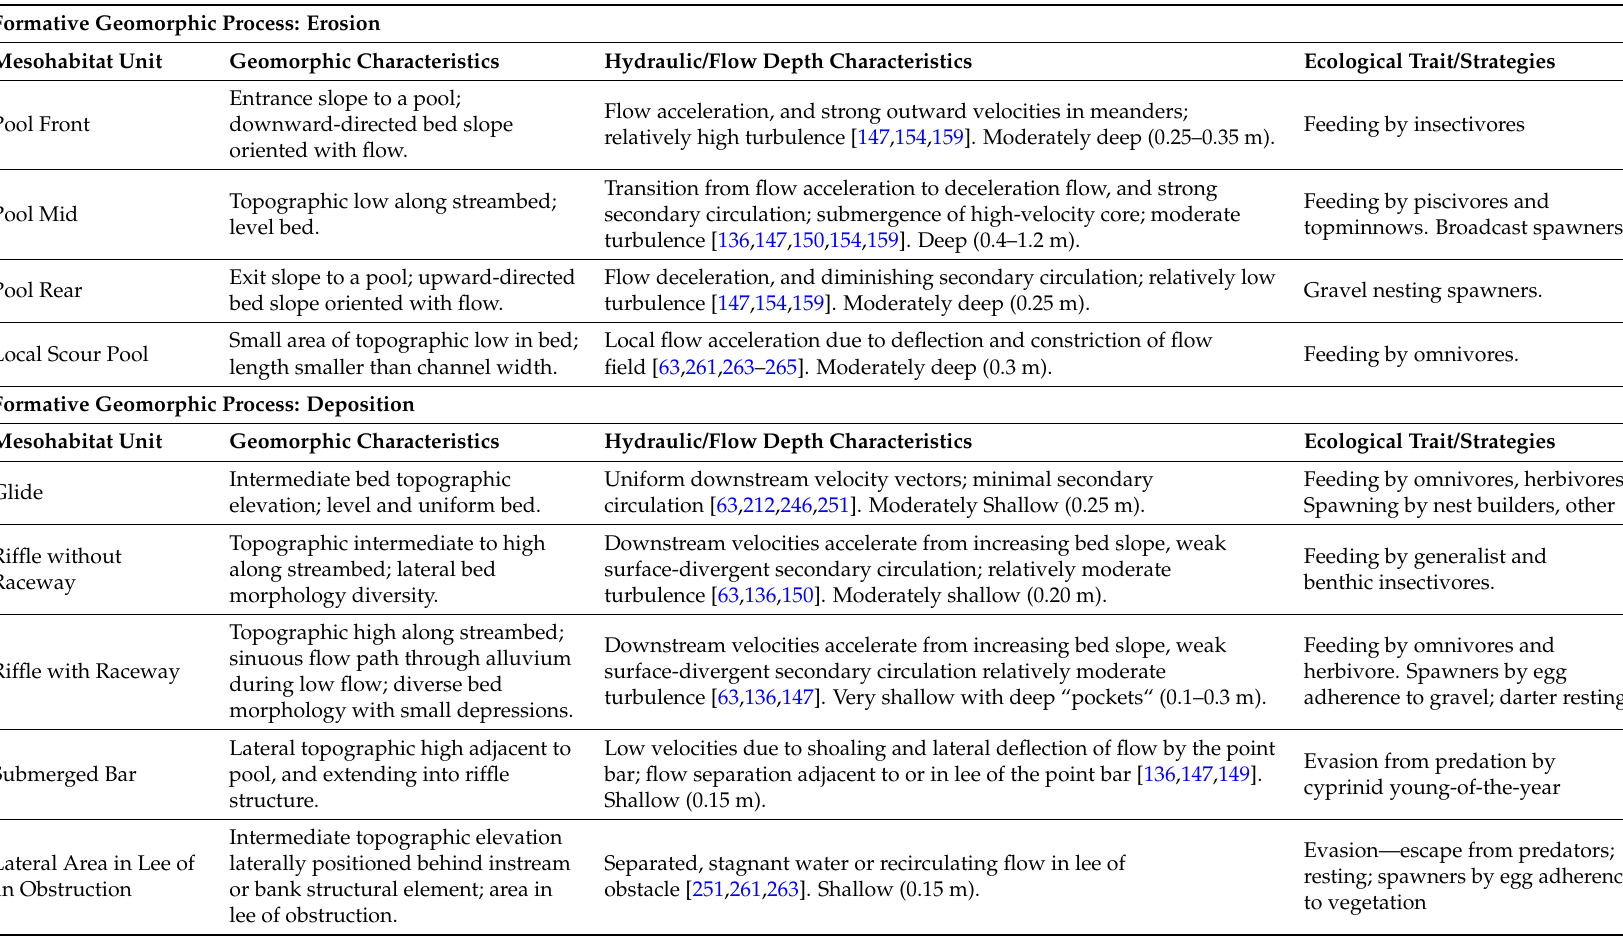
Table 2. Geomorphological and hydraulic characteristics of low-flow mesohabitat units in low-gradient streams of the US Midwest. Classification characteristics adapted from [79]; and example ecological traits/strategies based on species occupancy